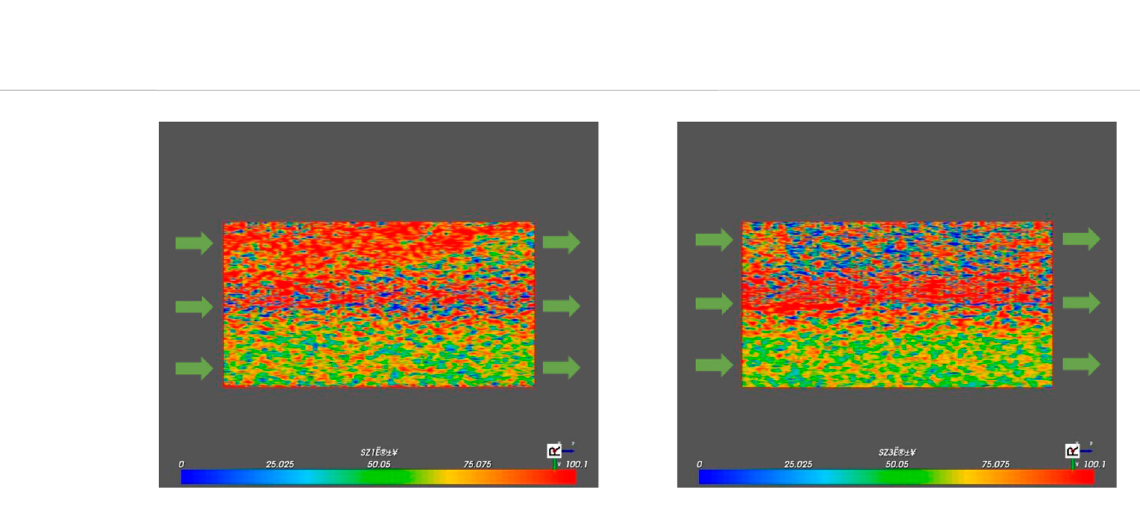
FIGURE 13 Final oil-water saturation distribution of SZ1 (left image) and SZ3 (right image) model respectively.